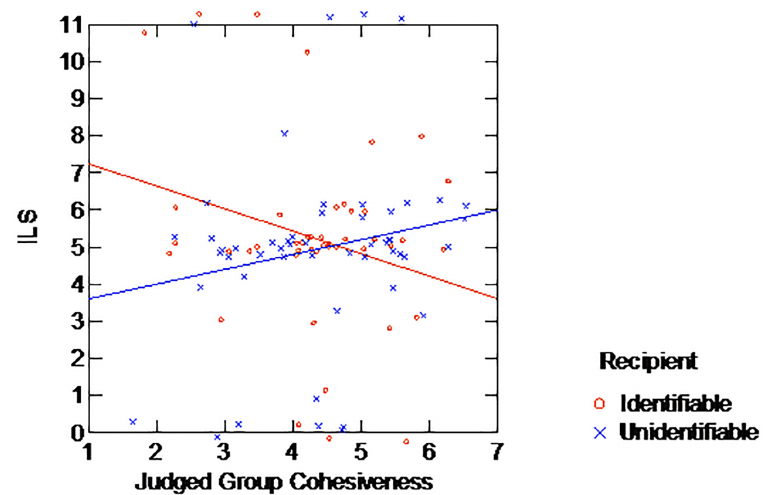
Fig 3. Mean allocation by recipient’s identifiability and perceivedgroup’s cohesiveness, Experiment 3.